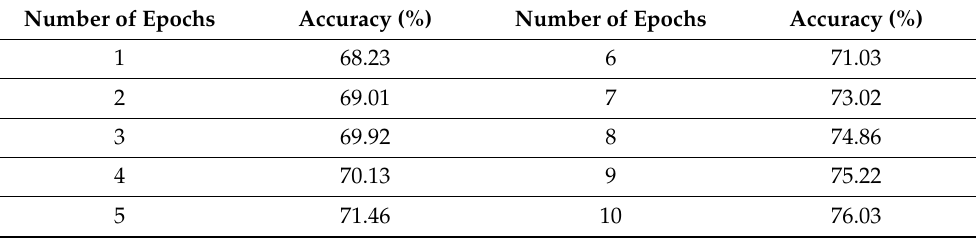
Table 4. Identification accuracy results of 16 irradiance distribution categories through 10 learning epochs.